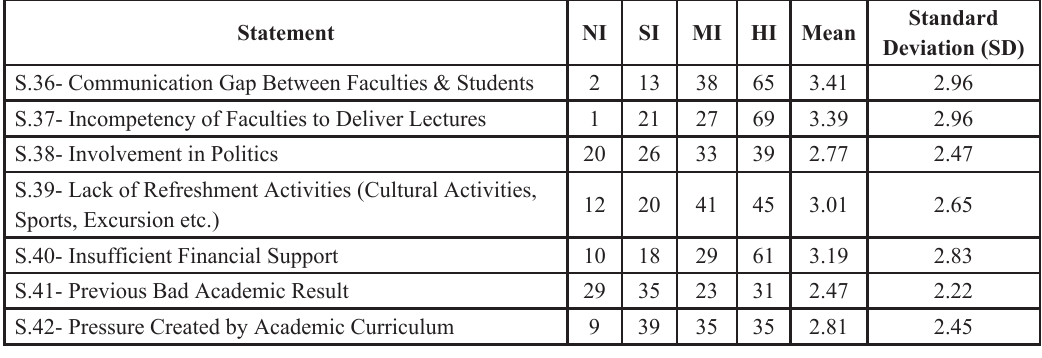
Table 4: Influential Statements and their Outcomes (S.35 to S.42)